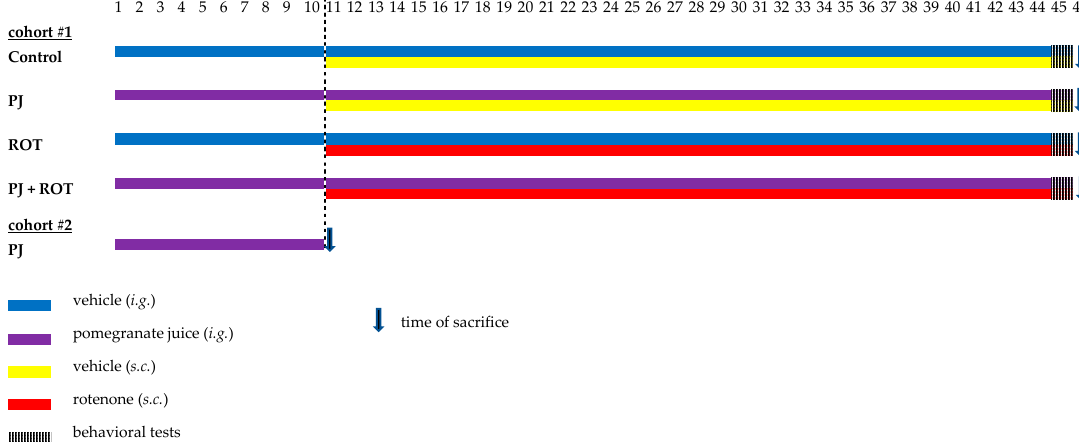
Figure 10. Schematic representation of the experimental design used in the Figure 9. Schematic representation of the experimental design used in the study.